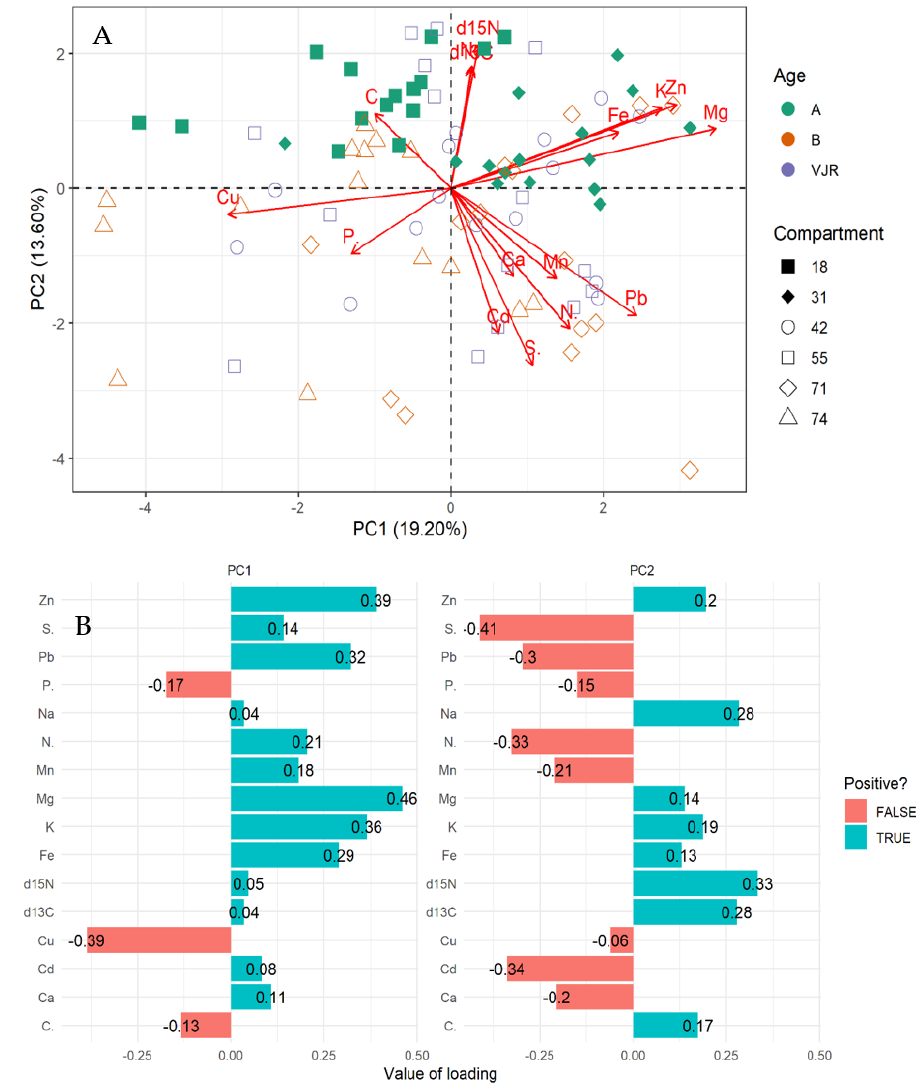
Figure 1. Relationship between elements in Rhizophora apiculata leaves, compartment, and compart- ment ages in the Matang Mangrove Forest Reserve, as determined by principal component analysis biplot ( A ) and loadings ( B ).